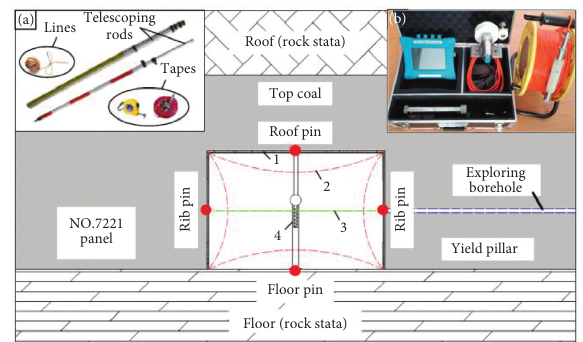
Figure 12: Borehole camera exploration and portable telescopic rod in the monitoring station.